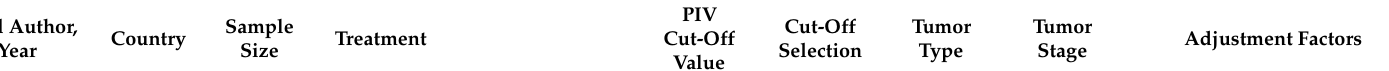
Table 1. Baseline characteristics of included